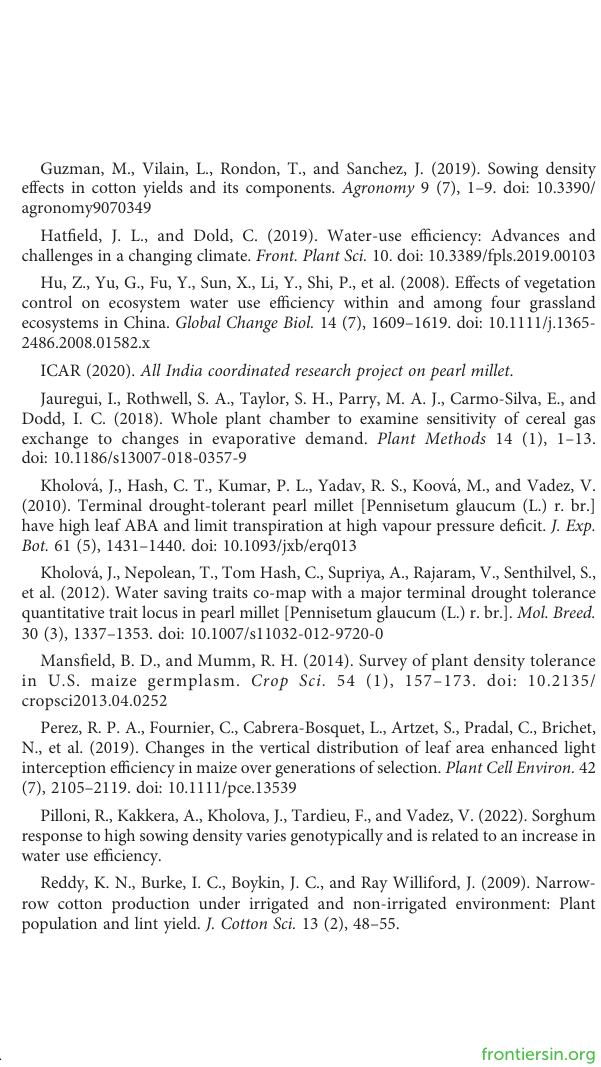
SUPPLEMENTARY FIGURE 1 Schematic of the sowing pattern in both high and low density in the fi elds in India (A) and the three densities in the fi elds in Senegal (B) . SUPPLEMENTARY FIGURE 2 Schematic of a replication in both high and low density, which consisted in four tubes in the two lysimetric platform in both India and Senegal (A) . Schematic representing an overview of a lysimetric trial with several replications set up on the platform (B)